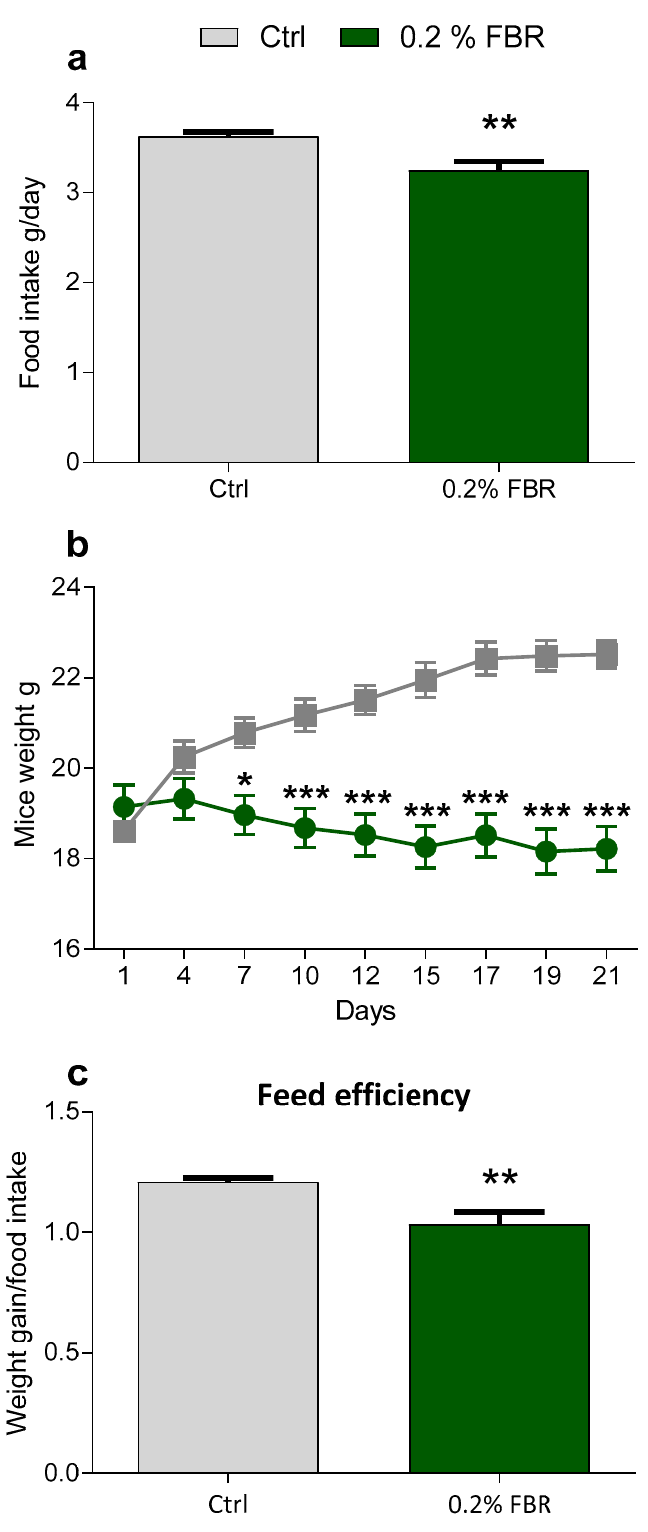
Figure 1. ( a ) Mean food intake (g/day); ( b ) time course of mice weight in g of mice fed a control diet (Ctrl, grey) or a 0.2% FBR‑supplemented diet (0.2% FBR, green); ( c ) feed efficiency calculated as percentage of weight gain with respect to time 0 (t0) divided by food intake expressed as percentage of mice fed the control diet. Data are presented as mean ± SEM of n = 10. * p ≤ 0.05; ** p ≤ 0.01; *** p ≤ 0.001.